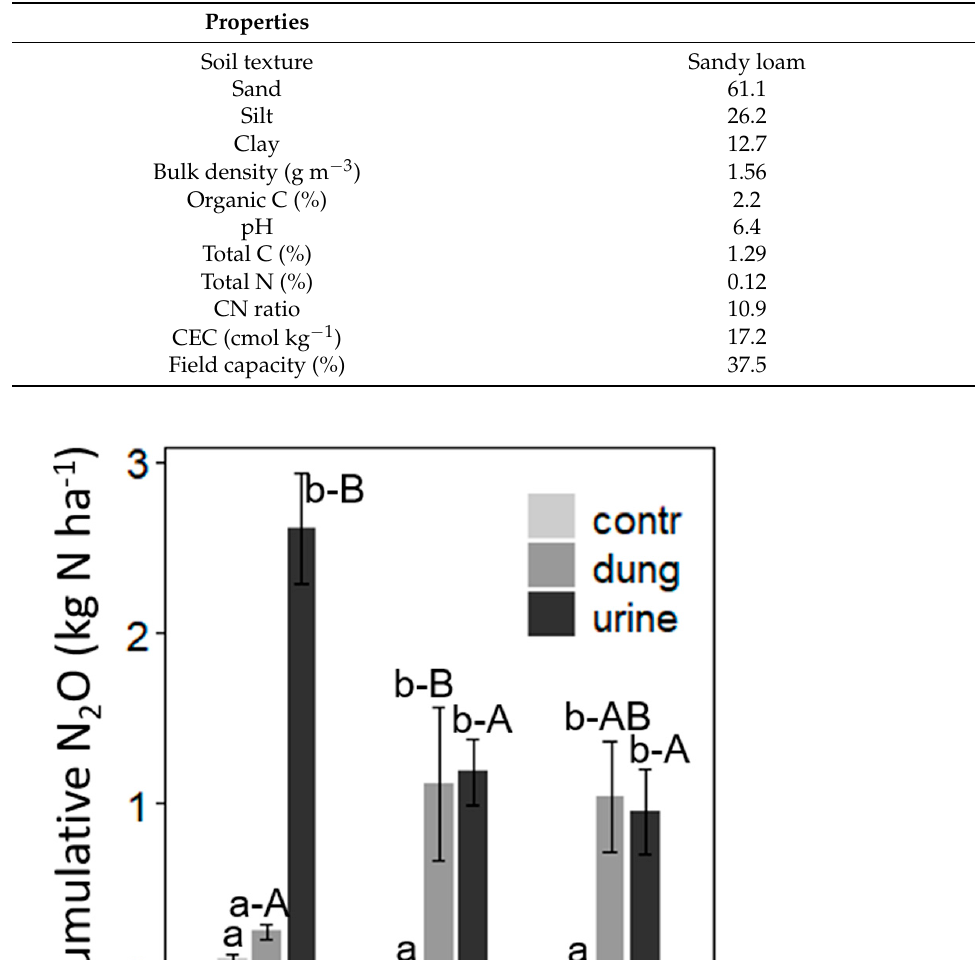
Table A1. Physical and chemical properties of the soil at the experimental site (30 cm soil depth).